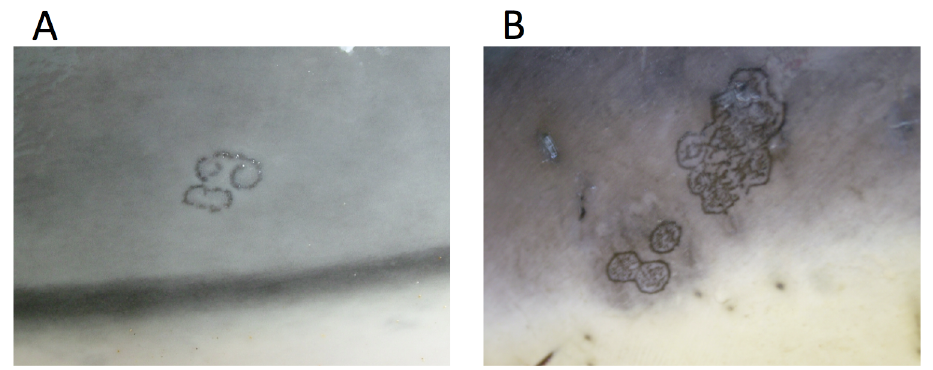
Fig 1. Tattoo lesions seen in cetacean poxvirus-infected animals. Tattoo lesion on the thorax of a juvenile male striped dolphin ( Stenella coeruleoalba ) (a) and tattoo lesion on the thorax of a juvenile female common dolphin ( Delphinus delphis )